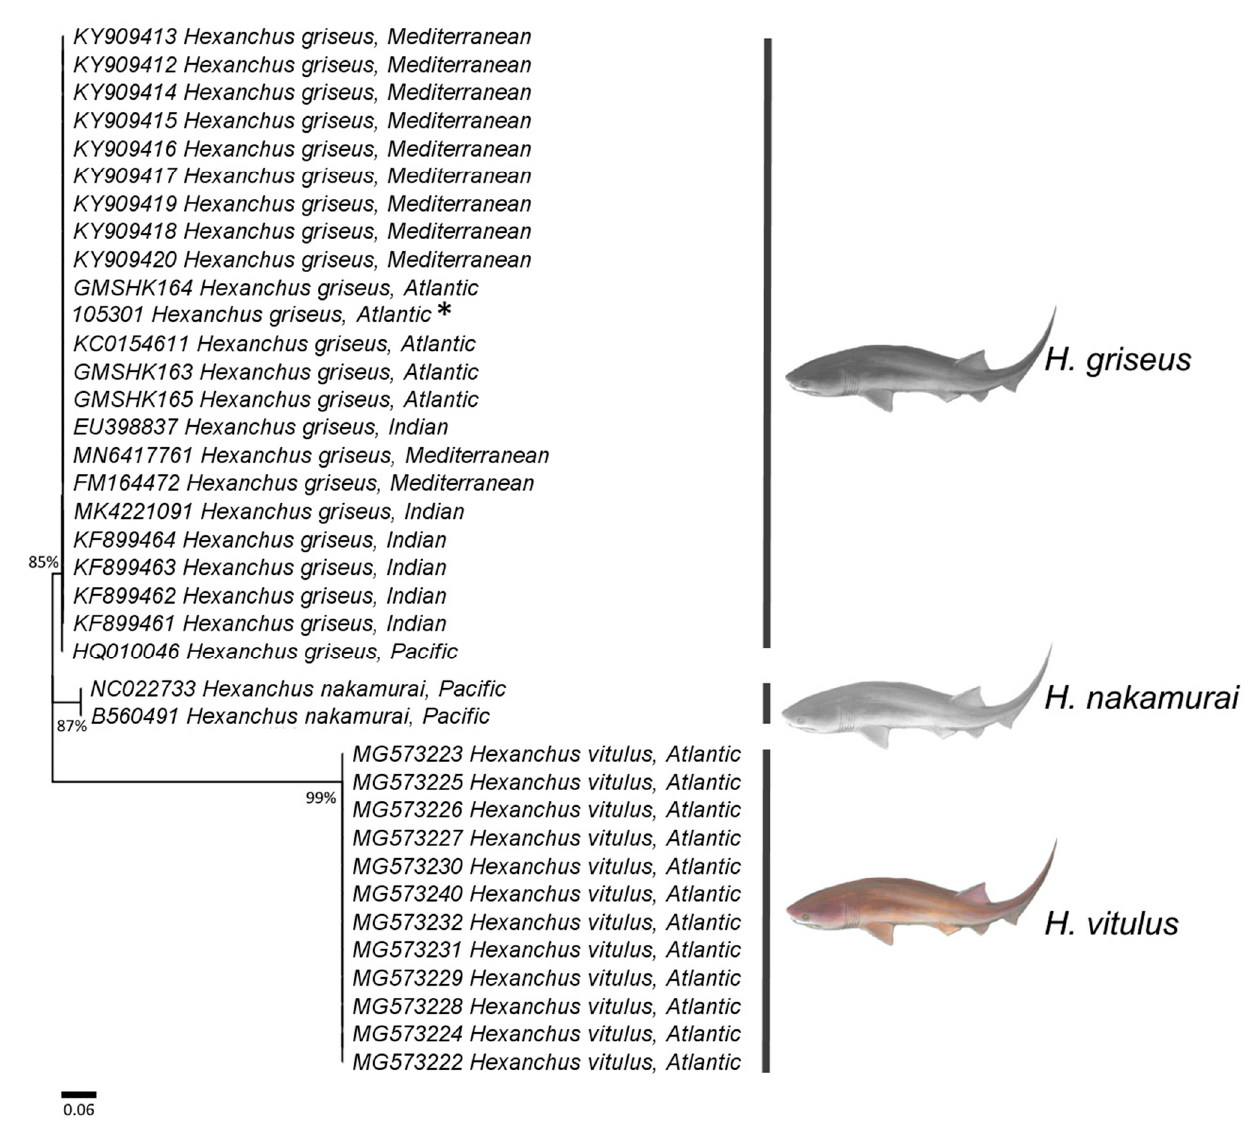
Figure 3. Relationships between Hexanchus spp. based on a maximum likelihood analysis and inferred from mitochondrial cytochrome c oxidase subunit I (COI) gene sequences. All nodes displayed bootstrap values above 85%. * indicates the sample collected in the present study.